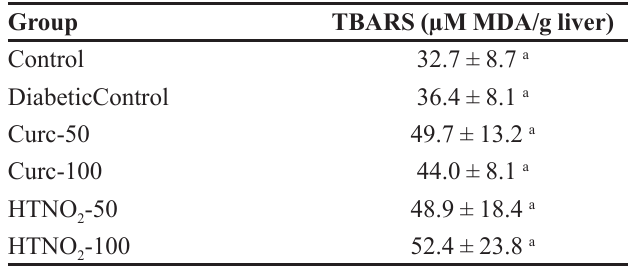
TABLE IV - Mean values obtained on formation of thiobarbituric acid reactive substances (TBARS) assay in liver samples